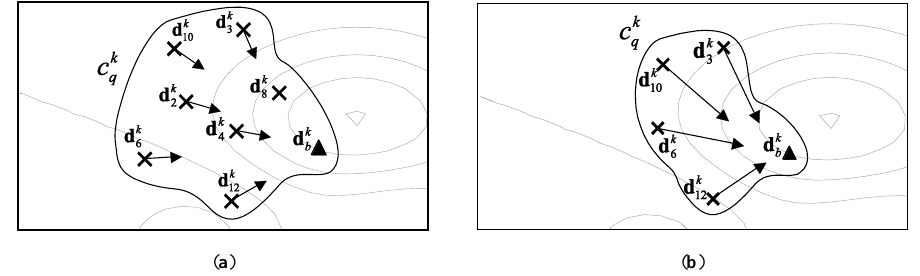
Figure 1. Local attraction operation in two scenarios: ( a ) cluster containing several elements ( b ) cluster containing few elements. The arrows represent ( a ) small search capabilities (low exploitation, high exploration) inside the cluster and ( b ) large search capabilities (high exploitation, low exploration) inside the cluster.